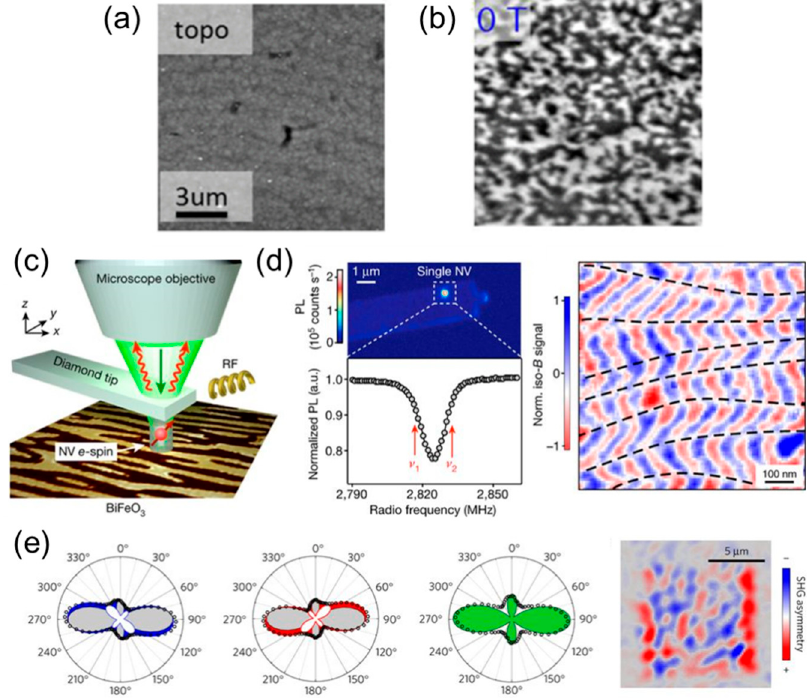
Figure 7. ( a , b ) Topographic, and MFM image of the h-LuFeO 3 film at 50 K after zero-field cooling. Reprinted with permission from [133], copyright the American Physical Society, 2017. ( c ) The electronic spin of a single NV defect placed at the apex of a diamond scanning-probe tip is used as an atom-sized magnetic field sensor. ( d ) Top panel, photoluminescence scan of the diamond scanning-probe showing the bright emission from a single NV defect. Bottom panel, spectrum recorded while applying a bias field along the NV axis. Magnetic field image of the BFO film, the black dashed lines are attributed to ferroelectric domain walls leading to abrupt rotations of the cycloidal propagation vector. Reprinted with permission from [129], copyright Springer Nature, 2017. ( e ) Polar plots of the SHG dependence on the incident light polarization direction (with vertical analysis) with fits of the SHG data, composed of the time-invariant (ferroelectric) part (grey areas) and the time-noninvariant (antiferromagnetic) part (white areas). Reconstructed image of the antiferromagnetic texture in BFO sample, color scale representing the asymmetry of the SHG polar plots. Reprinted with permission from [141], copyright Springer Nature, 2019.